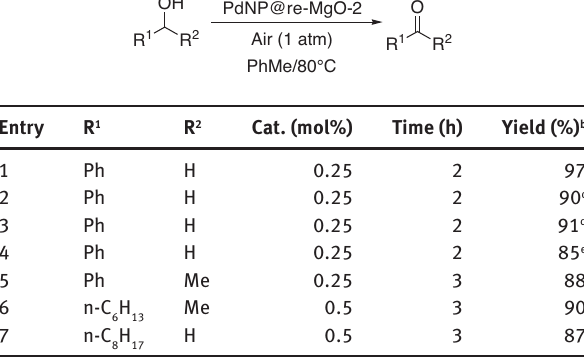
Table 2: PdNP@re-MgO-2 catalyzed aerobic oxidation of alcohols. a